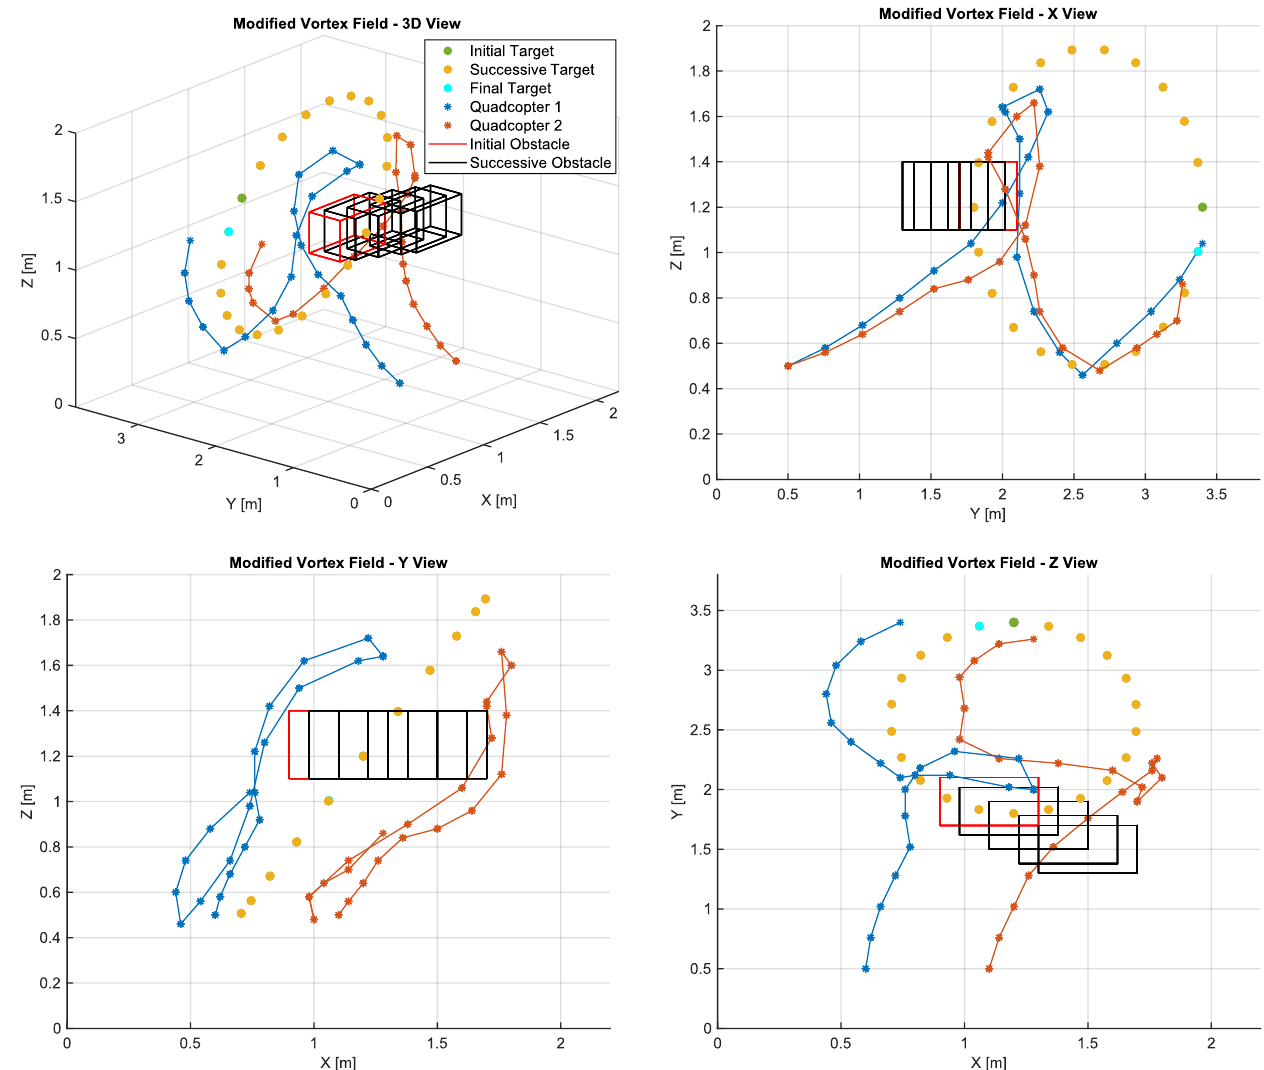
Figure 7. Path calculated by the proposed vortex field APF.